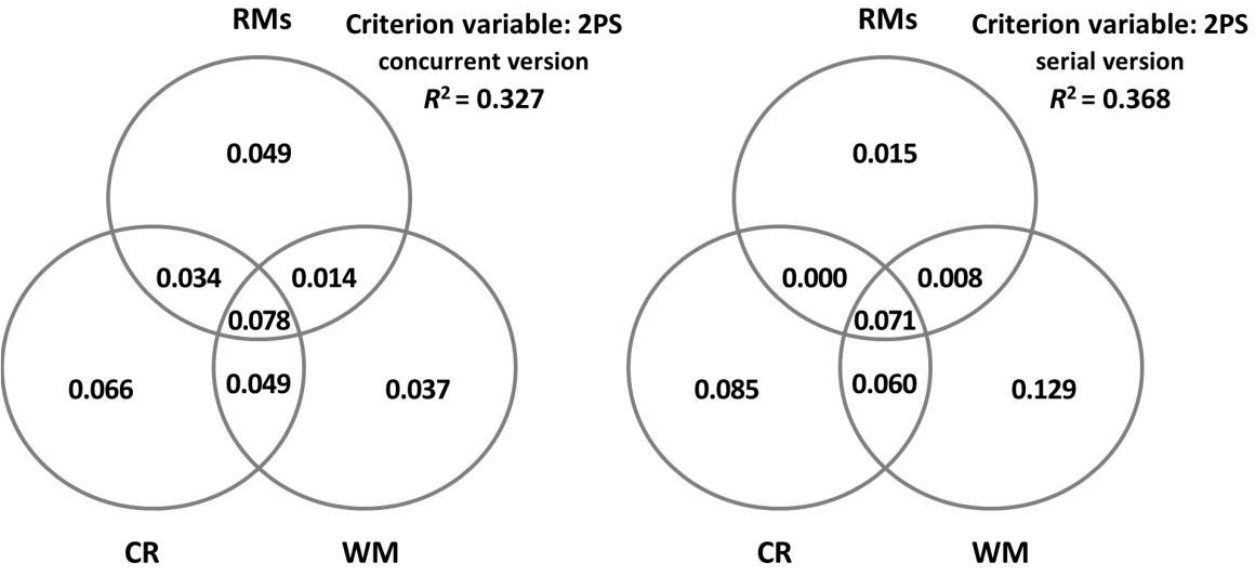
Figure 6. Decomposition of the variance in two-proposition sentences (2PS) explained jointly and uniquely by cognitive reserve (CR), measured by the cognitive reserve questionnaire (CRQ); working memory (WM), measured by the digit ordering task (DO); and the rest of the measures (RMs: age, MMSE, GDS-15, and MFE). Finally, Table 9 presents a summary of the results of the regression analyses for the different measures of sentence